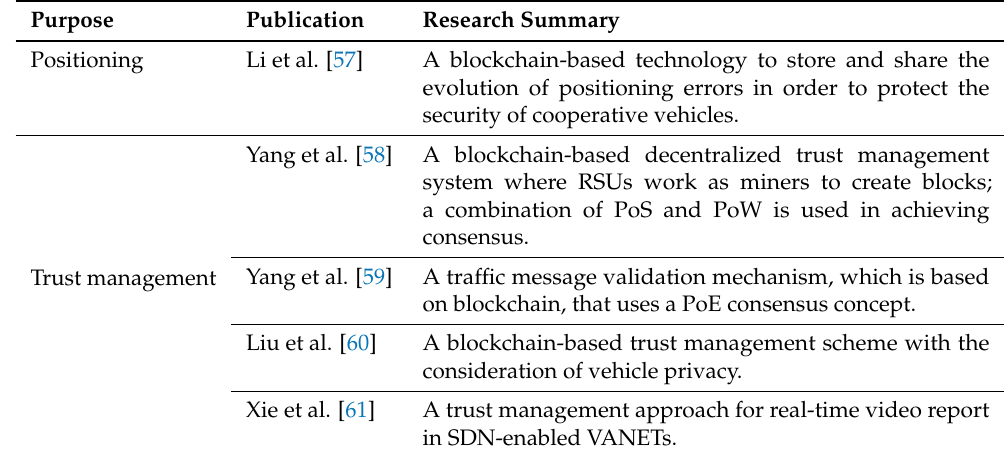
Table 2. Blockchain for perception layer issues in vehicular